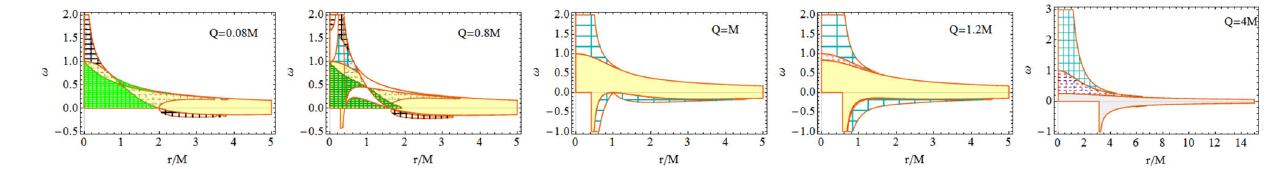
Fig. 28 Equatorial plane of the Kerr–Newman spacetime: generalization of the analysis of Fig. 10 to the case Q (cid:20)= 0 – see also Fig.